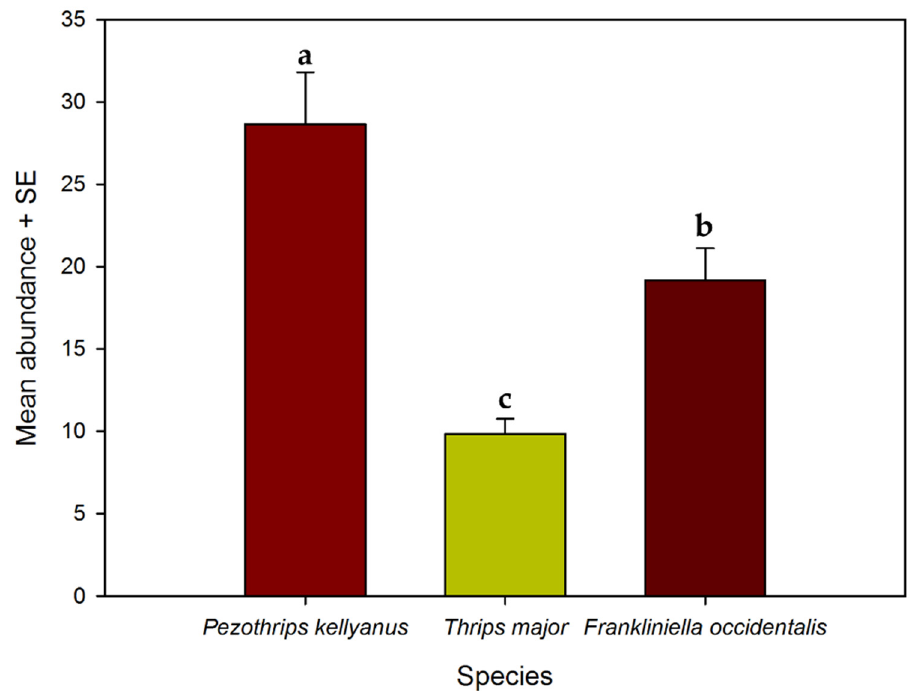
Figure 5. Abundance of different thrips species on Citrus spp. The different superscript letters show a significant difference among the means’ values ( p < 0.05).